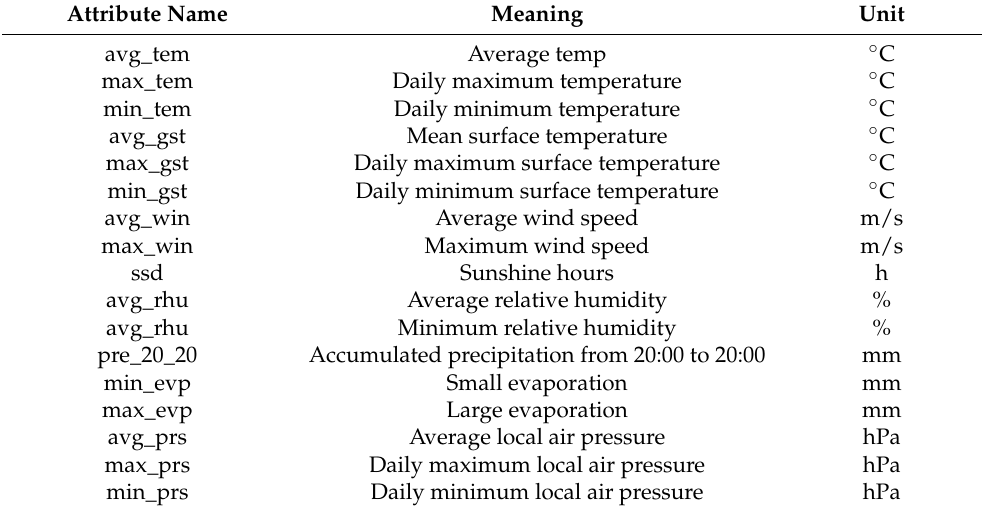
Table 1. Original meteorological data.